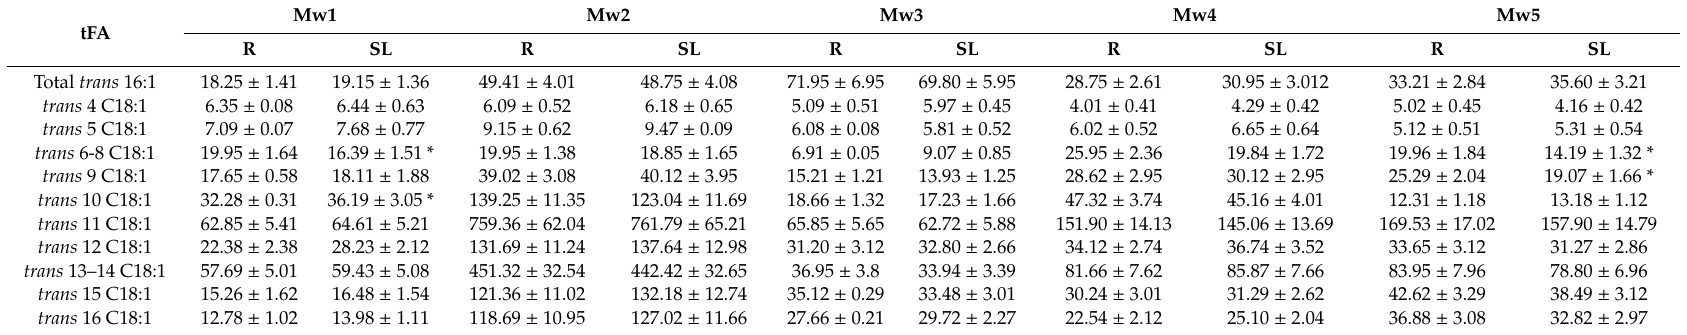
Table 4. Trans monoenoic fatty acid isomers composition (mg FA / 100 g of total FA ± Standard Deviation (SD) at the reception (R) and at the end of shelf life (SL) in commercial PUFA UHT-enriched milk.